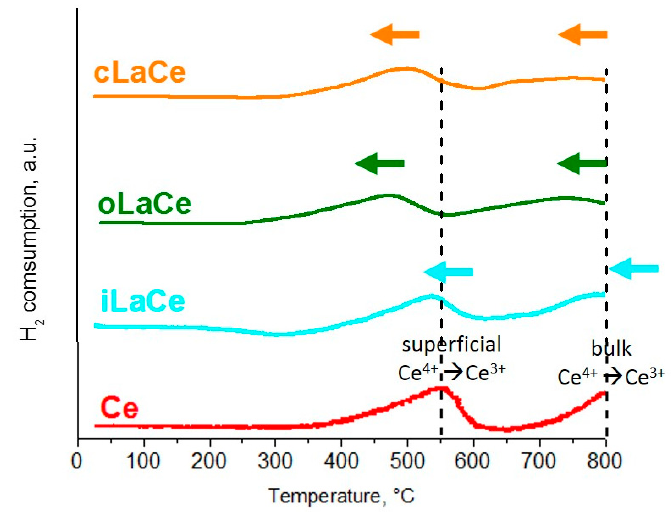
Figure 5. TPR profiles for the plain supports.